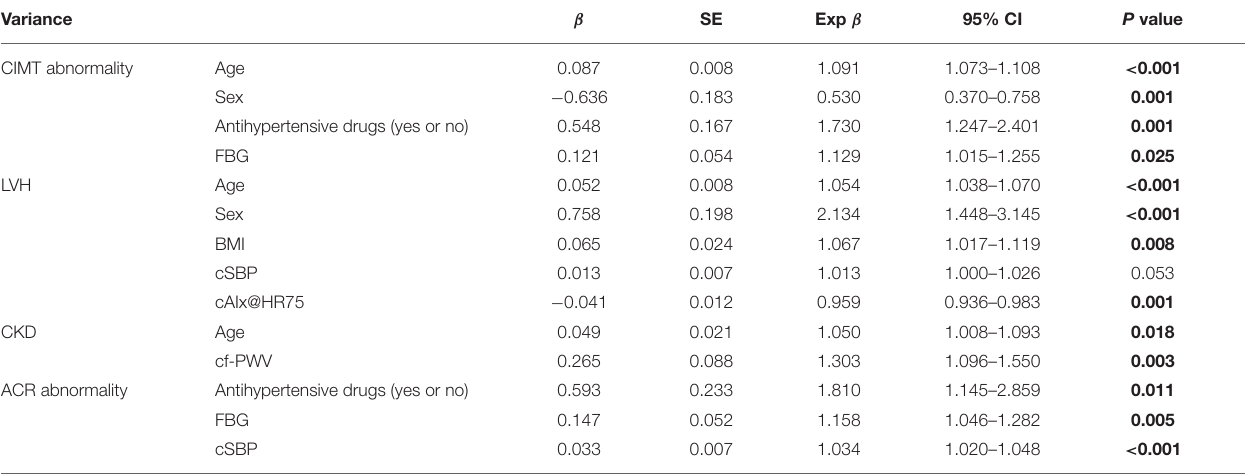
TABLE 3 | Multiple stepwise logistic regression of risk factors of target organ damage in the overall studied population. Variance